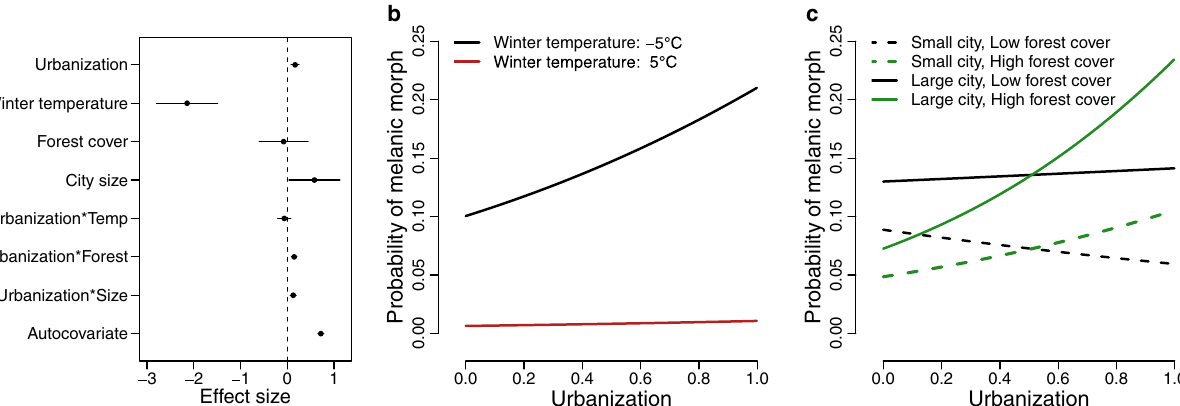
Figure 2. ( a) Effect sizes for fixed effects of urbanization, winter temperature, forest cover, city size, interaction terms with urbanization, and a spatial autocovariate from a linear mixed model of melanism in 26,924 eastern gray squirrels (Sciurus carolinensis ) among 43 cities in North America. Effect sizes represent standardized regression coefficients and include 95% confidence intervals. ( b) Relationship of the probability of melanism to urbanization at low (− 5 °C) and high (5 °C) winter temperature while holding city size and forest cover constant. c , Relationship of the probability of melanism to urbanization at varying levels of city size and forest cover. Effects of urbanization on melanism are shown for combinations of small cities (25,000 ha), large cities (350,000 ha), low forest cover (15%), and high forest cover (45%) while holding winter temperature constant at − 5 °C. Urbanization was measured as standardized impervious cover in all